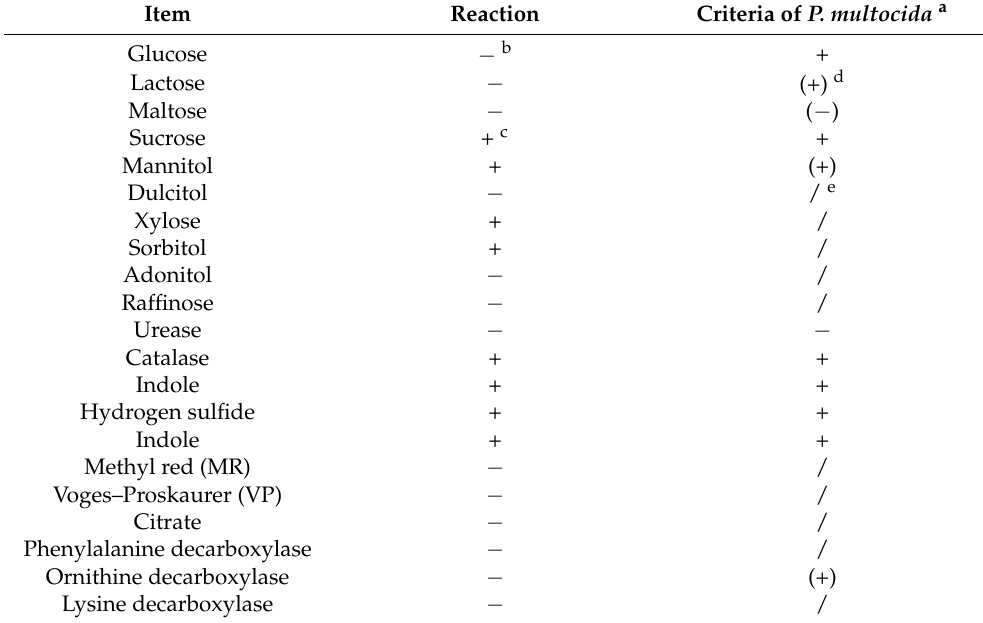
Table 5. Biochemical characteristics of the isolated bacteria. Reaction Criteria of P. multocida